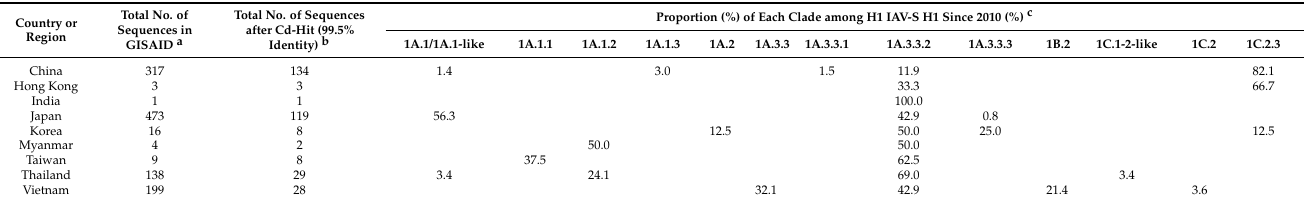
Table 1. Prevalence of each clade of IAV-S H1 isolates in each Asian country since